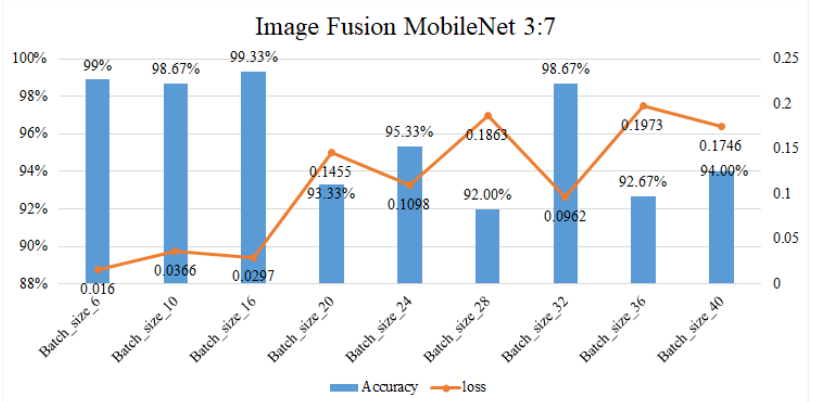
Figure 13. Accuracy and loss ratio when the fusion ration is 3:7 in